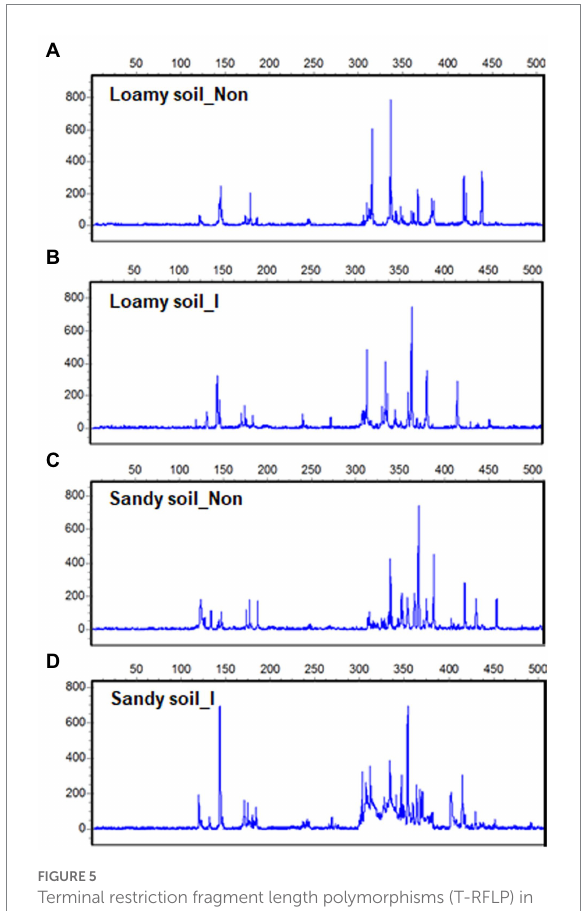
FIGURE 5 Terminal restriction fragment length polymorphisms (T-RFLP) in soil bacterial 16S rDNA from the rhizosphere of maize seedlings with inoculation and non-inoculation under loamy and sandy soil with supplemental application of tricalcium phosphate (TCP). One out of 3T-RFLP profiles was shown for loamy soil with